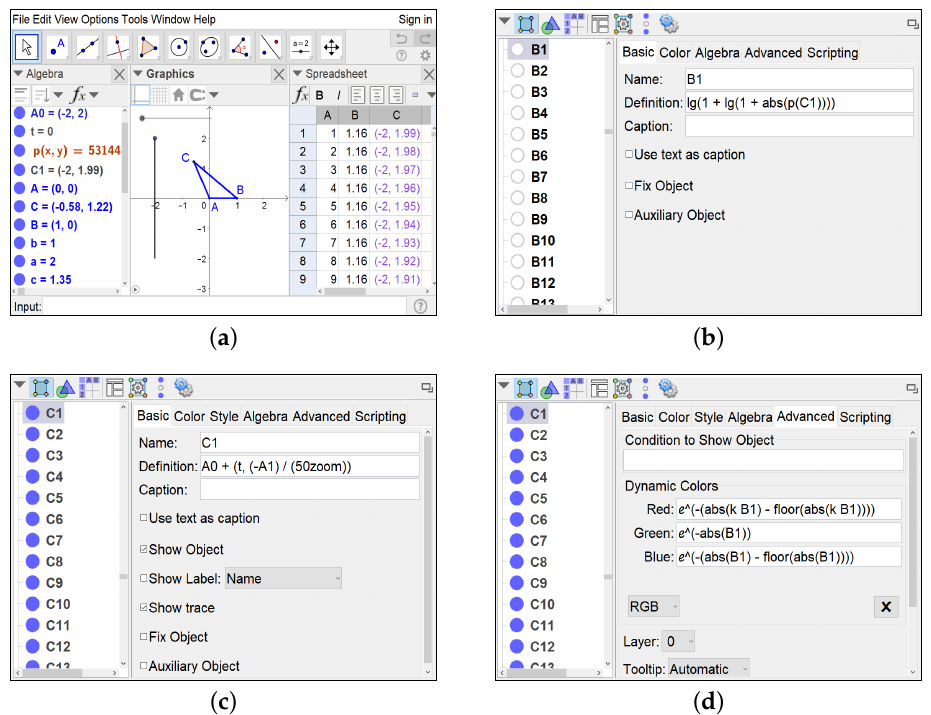
Figure 13. ( a ) Setting up the dynamic color scanner. ( b , c ) Basic parameters of the scanning points. ( d ) Parameter values for the RGB channels.